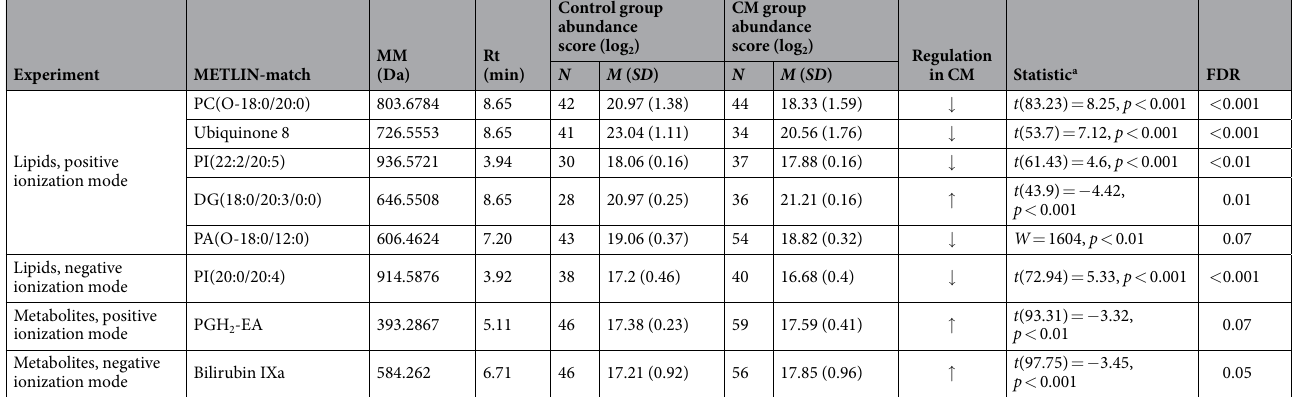
Table 2. Results of univariate group comparisons. Abundance scores quantify the metabolite and lipid fractions. Only METLIN database-matched compounds with significant group comparisons after multiple testing correction with a False Discovery Rate (FDR) ≤ 0.10 are displayed; CM = childhood maltreatment; CTQ = Childhood Trauma Questionnaire 23,24 ; MM = Monoisotopic mass in Da; Rt = Retention time in min. a For normally distributed continuous data Welch’s t -test was calculated, if residuals were not normally distributed Mann-Whitney- U -test was